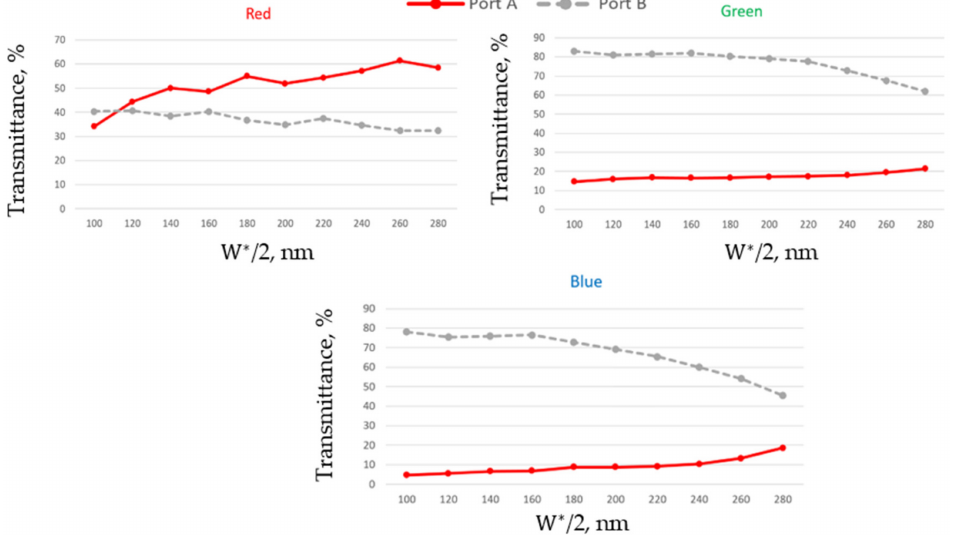
Figure 5. Total transmittance measured for three different RGB colors as a function of the distance between the deep-trenches at normal incidence and d ARC = 200 nm, d A = d B = 100 nm, d DT = 100